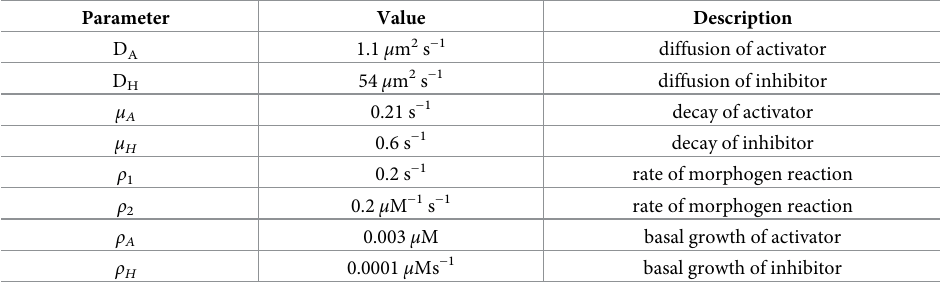
Table 1. Parameter values used in the model to reproduce wild-type